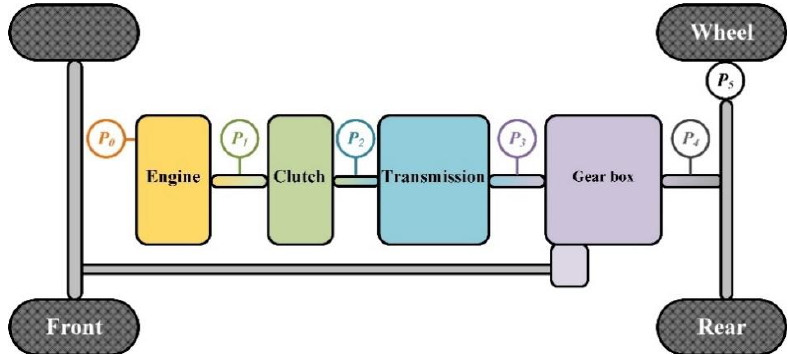
Figure 1. Topological diagrams of motors for a hybrid electric vehicle (HEV).